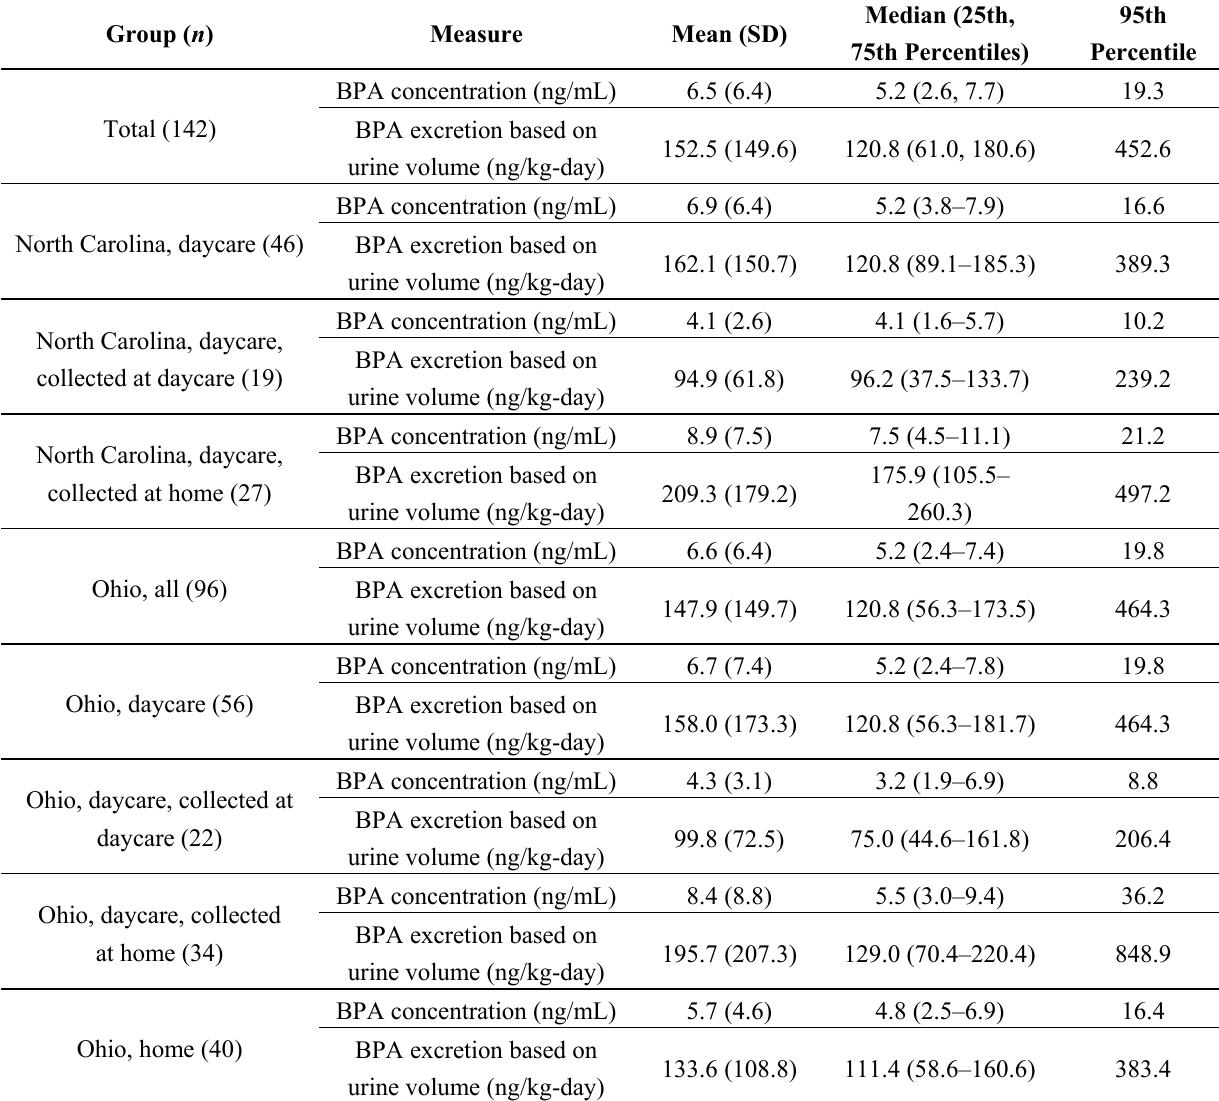
Table A5. BPA urine concentrations and estimated daily excretions based on Children’s Total (Aggregate) Exposure to Persistent Pesticides and Other Persistent Organic Pollutants (CTEPP) data, North Carolina and Ohio,